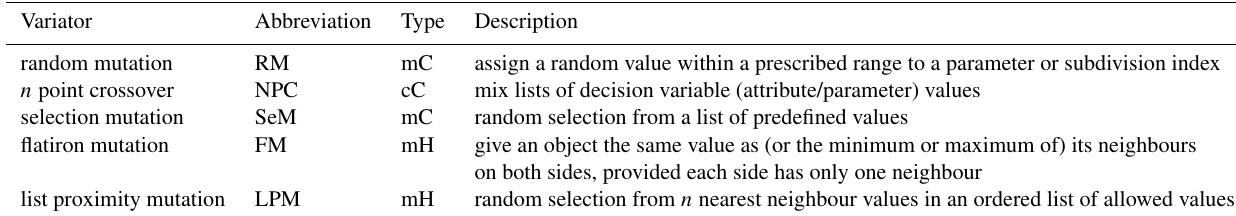
Table 1. Specific variators. Types include mutators (m) and crossover (c), classic (C) and heuristic (H). Variator Abbreviation Type Description random mutation